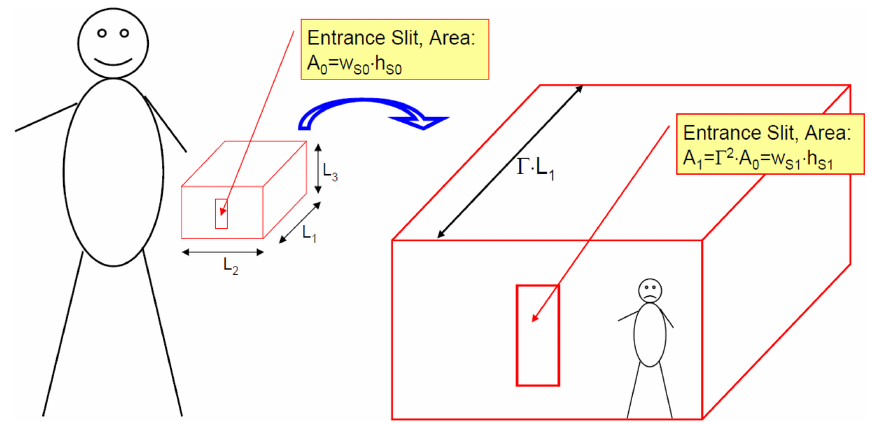
Figure 2. Scaling a spectrograph with the linear scaling factor (cid:48) at constant aspect ratio, i.e. preserving the ratio between the dimensions L 1 , L 2 , and L 3 as well as between L 1 and w S ( w S , slit extension in dispersion direction) and h S . For instance, a spectrograph scaled up by a factor of 10 in its linear dimensions would feature a 100 times higher étendue but have 1000 times the